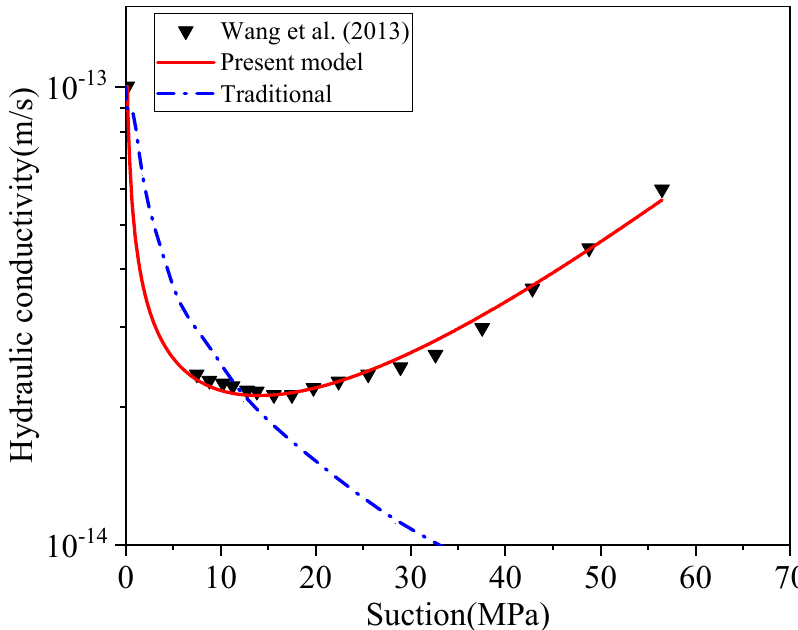
Figure 9. The prediction of unsaturated hydraulic conductivity for MX80 bentonite.